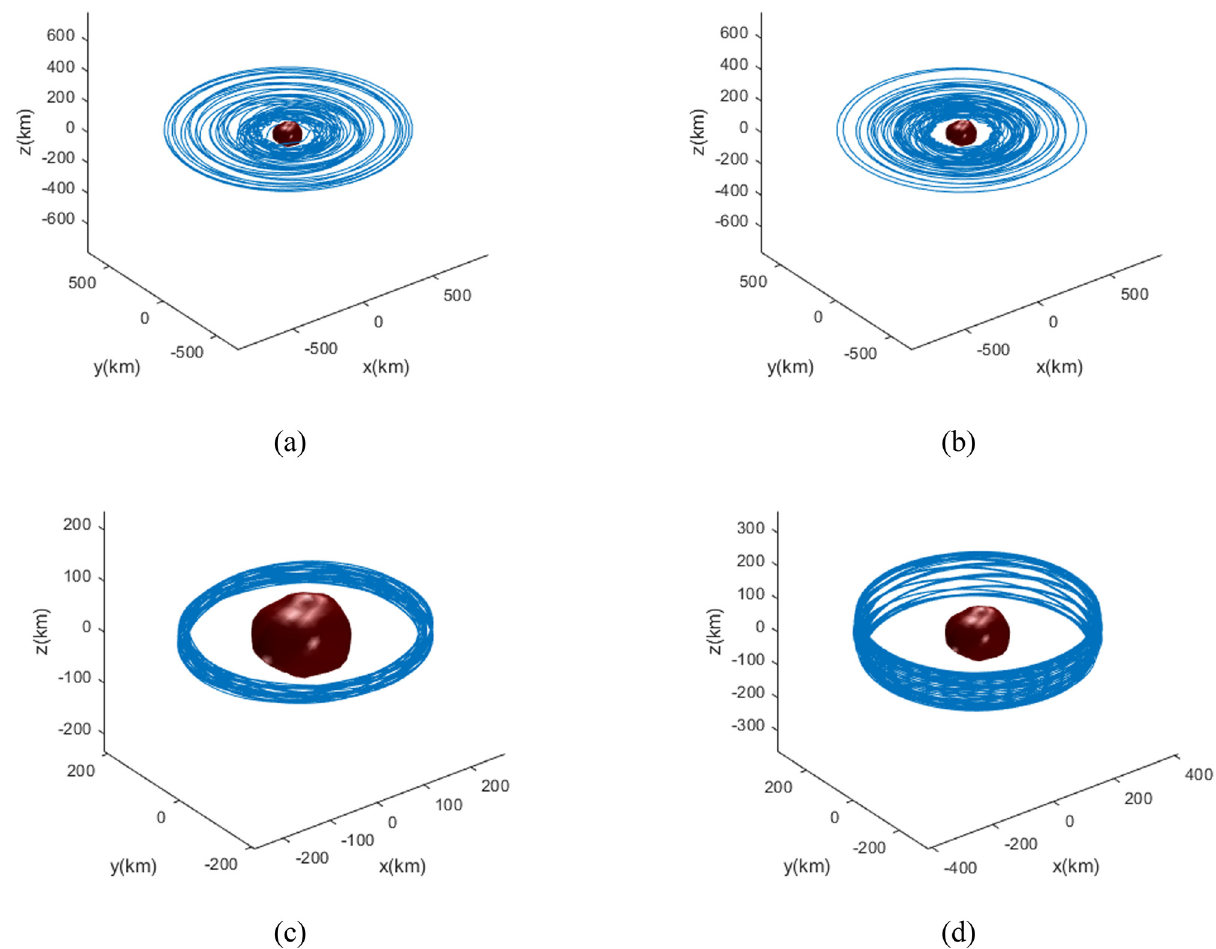
Figure 9: Orbits around Minerva in di ff erent initial distances ( d : initial distance ) . ( a ) d 150 km =